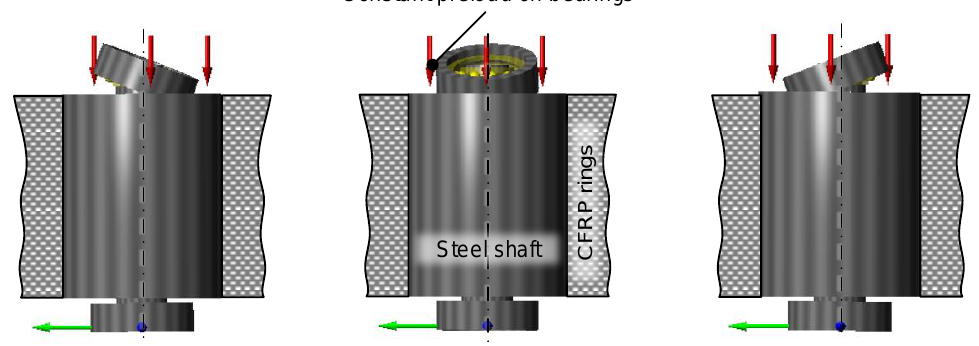
Figure 9. Rigid body mode of the bearing shield around 8000 rpm.